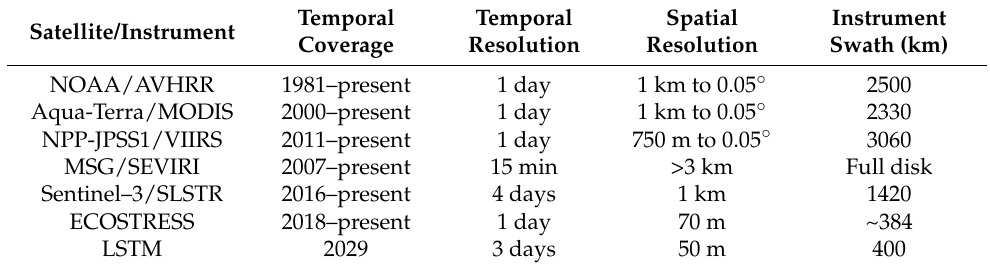
Table 1. Characteristics of different land surface temperature (LST) missions, past, present, and future.